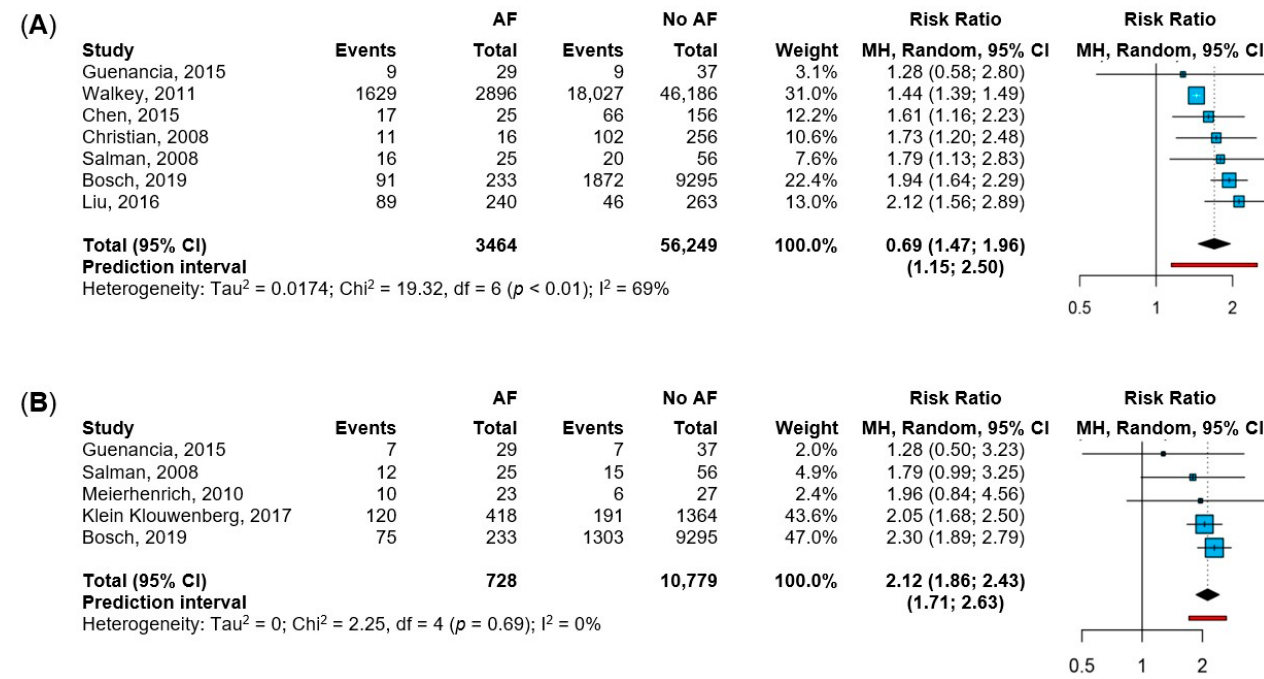
Figure 2. Impact of NOAF (new-onset atrial fibrillation) on in-hospital and ICU mortality. Legend: panel ( A ): in-hospital mortality [12,19–21,23,29,34]; panel ( B ): ICU (intensive care unit) mortality [19,23,25,30,34]. Abbreviations: AF = atrial fibrillation; MH = Mantel-Haenszel; CI = confidence interval; I2 = inconsistency index.